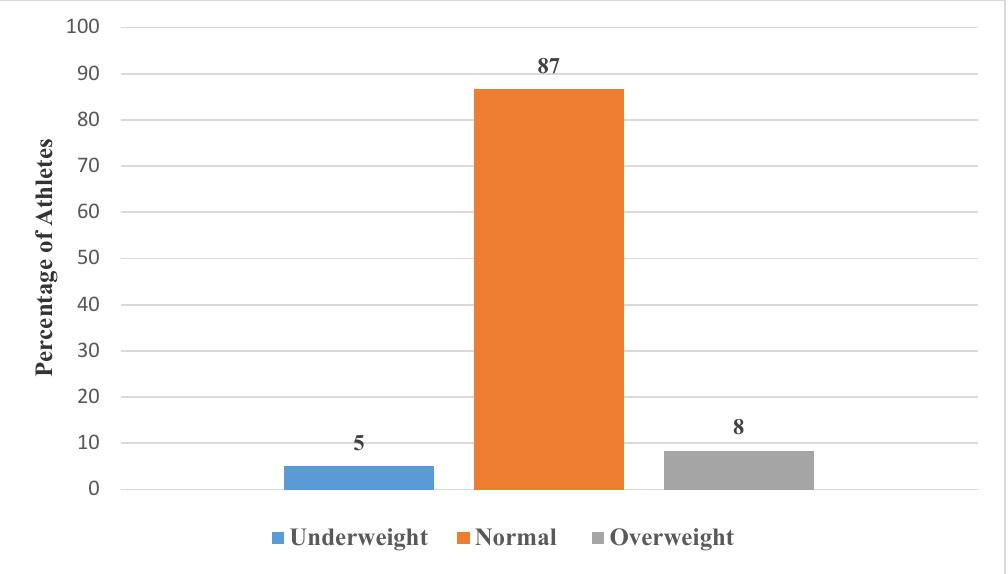
Figure 2. Macronutrient intake of athletes.